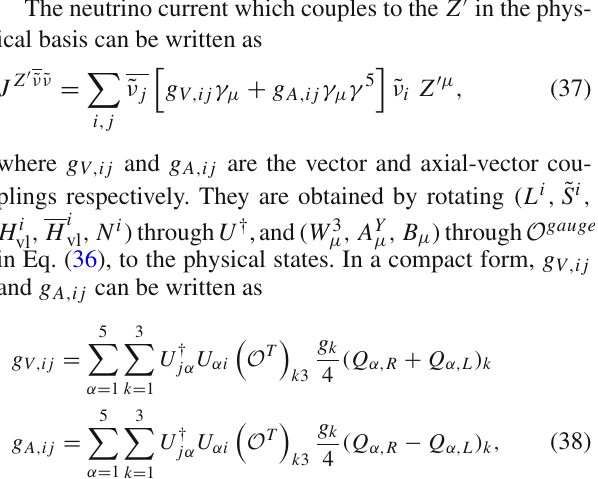
from Table 1 by flipping the respective charge signs.